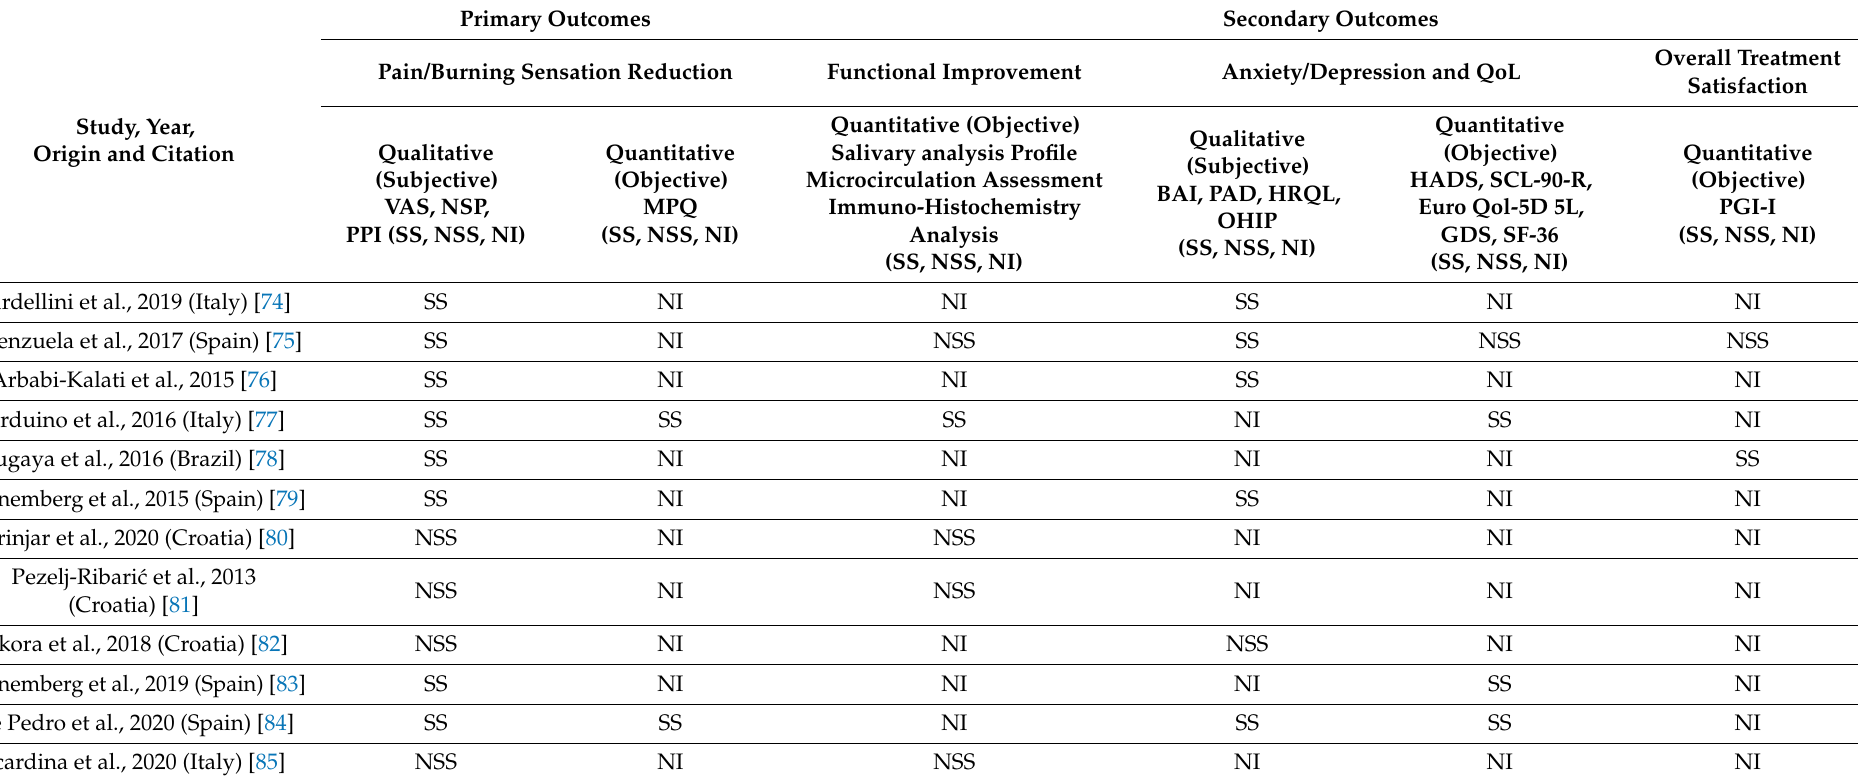
Table 4. Tabular description of all the selected eligible in vivo RCTs human studies of BMS, in terms of level of significance in subjective and objective assessments of pain, functionality improvement, anxiety reduction/QoL improvement and overall treatment satisfaction. Abbreviations: SS: Statistically significant; NSS: Not statistically significant; NI: No information. List of the abbreviations are listed in Supplementary File